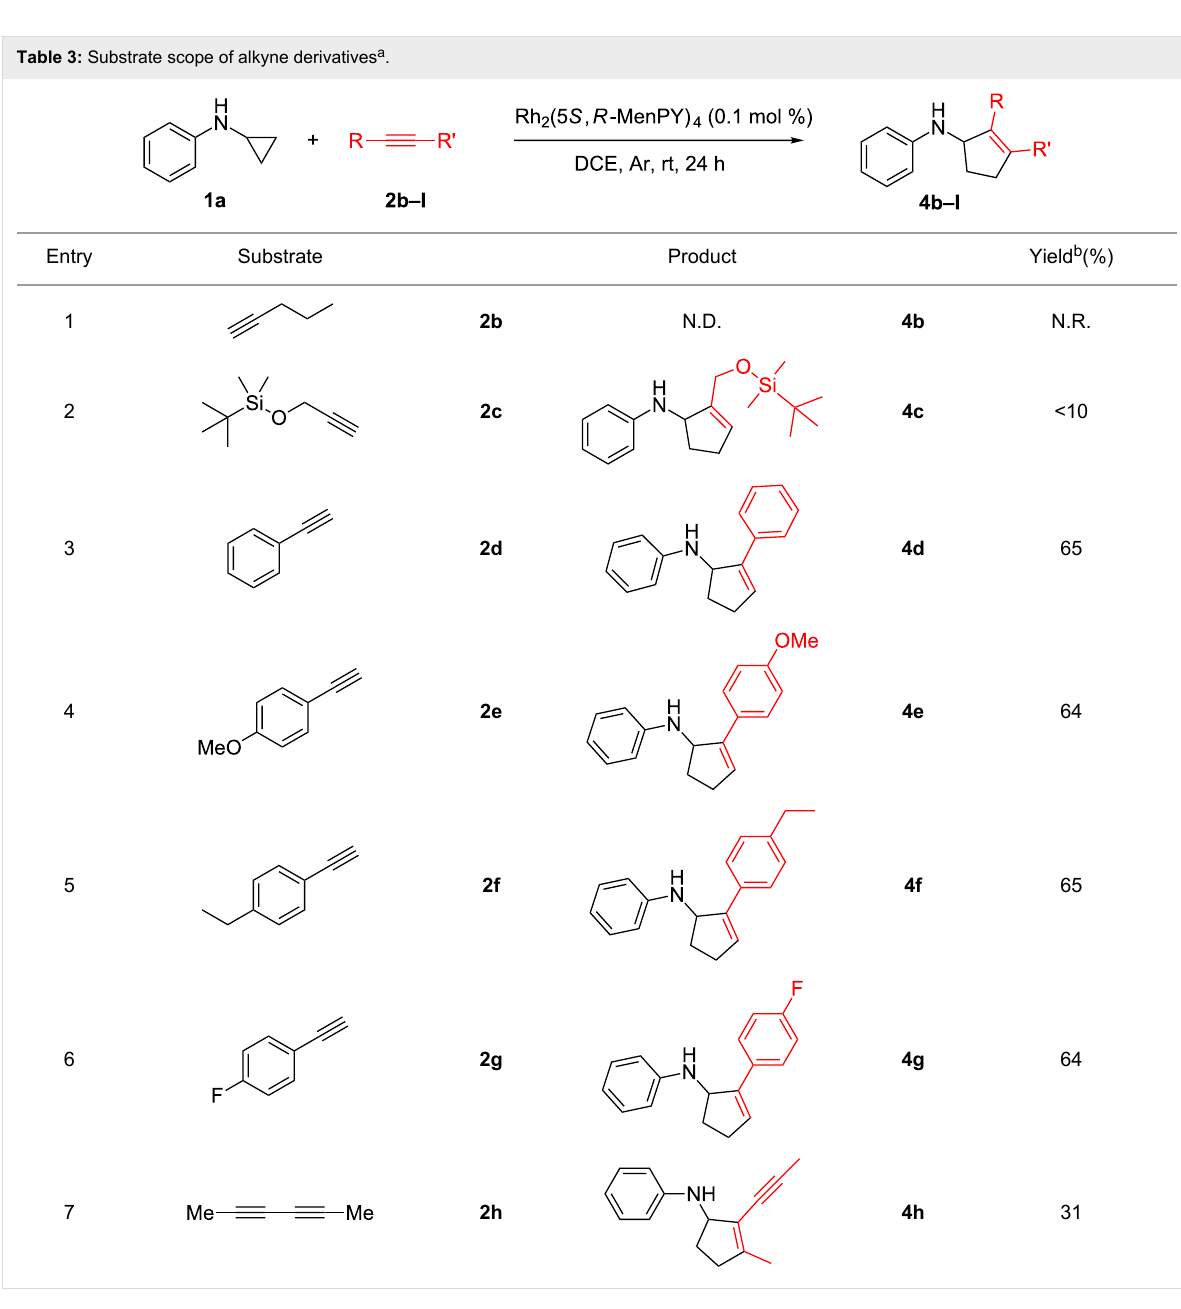
Table 3: Substrate scope of alkyne derivatives a